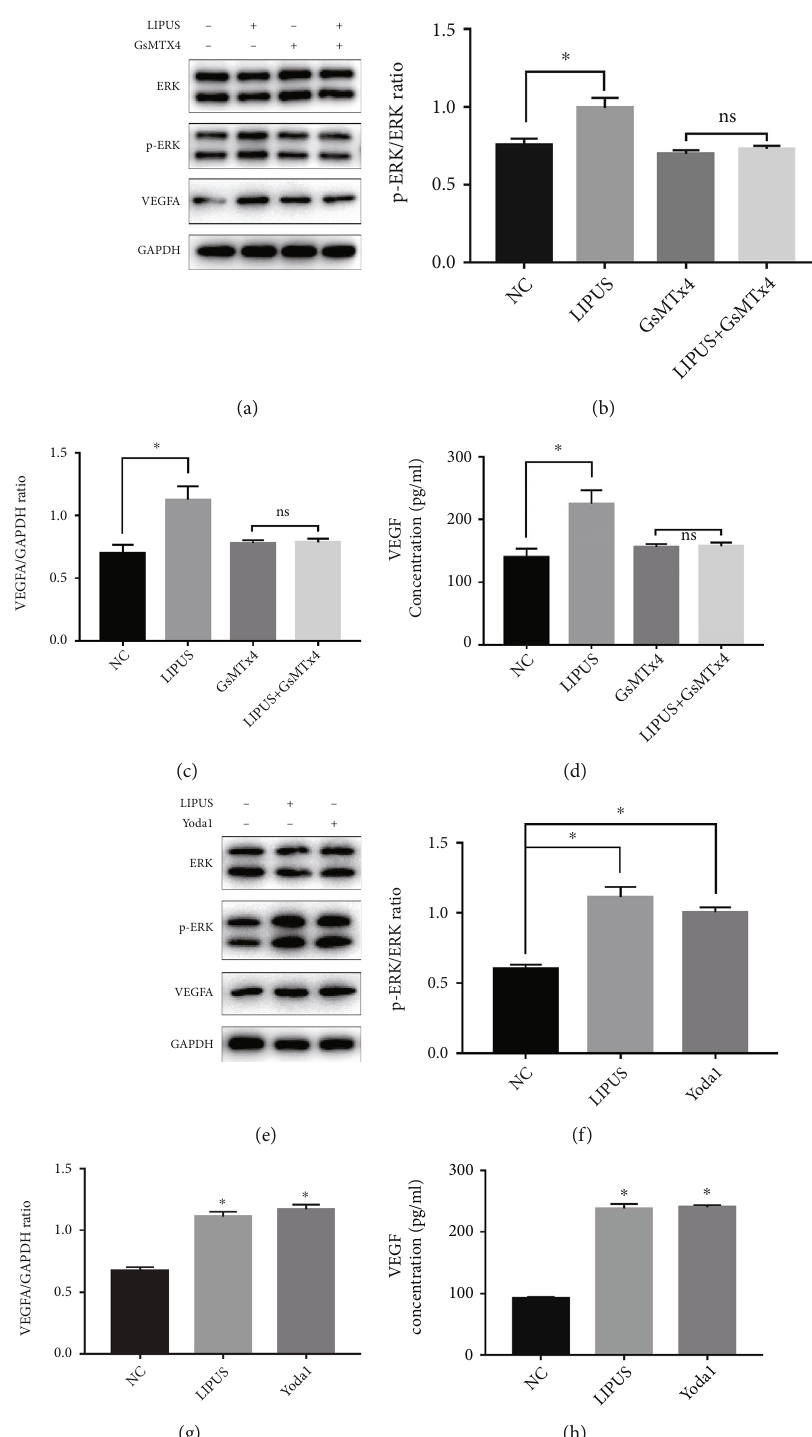
Figure 8: LIPUS activated the downstream pathway through the Piezo channel in ADSCs. (a) Western blot analysis of ERK, p-ERK, VEGFA, and GAPDH expression in ADSCs treated with LIPUS or GsMTX4, a selective Piezo channel inhibitor (ADSCs were pretreated with 5 μ M GsMTX4 for 1 hour). (b) The relative density of p-ERK compared with that of ERK. (c) The relative density of VEGF compared with that of GAPDH. (d) The concentration of VEGF in the supernatant of the cell culture medium. (e) Western blot analysis of ERK, p-ERK, VEGFA, and GAPDH expression in ADSCs treated with LIPUS or Yoda1, an agonist of the Piezo channel (ADSCs were pretreated with 30 μ M Yoda1 for 1 hour). (f) The relative density of p-ERK compared with that of ERK. (g) The relative density of VEGF compared with that of GAPDH. (h) The concentration of VEGF in the supernatant of the cell culture medium. Data are presented as the mean ± standard deviation. ns p > 0 : 05 when comparing the GsMTX4 group. ∗ p < 0 : 05 when comparing the NC